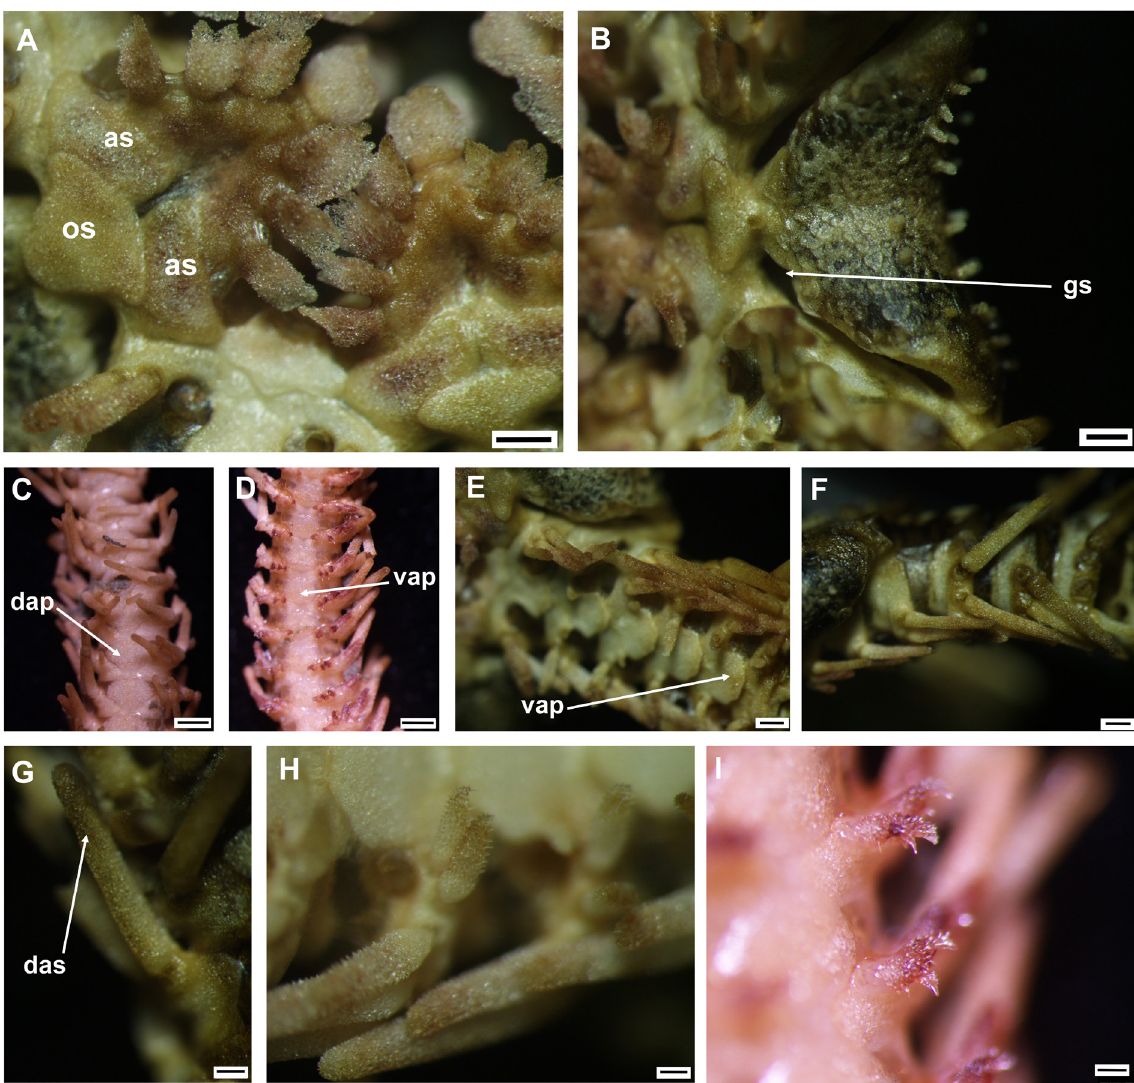
Fig. 21. Ophientrema scolopendrica (Lyman, 1883) (IDSSE EEB-SW0020). A . Oral frame. B . Lateral disc. C . Dorsal arm. D–E . Ventral arm. F . Lateral arm. G . Dorsal arm spine. H–I . Ventralmost arm spines on the arm. Abbreviations: as = adoral shield; dap = dorsal arm plate; das = dorsal arm spine; gs = genital slit; os = oral shield; vap = ventral arm plate. Scale bars: A–B, E–F = 500 µm; C–D = 1 mm; G–I = 200 µm. (A–B, E–H taken after thoroughly drying the